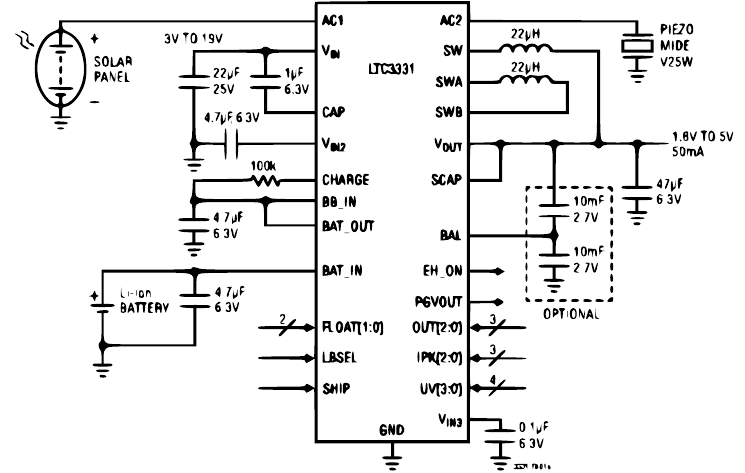
Figure 3. Typical application of the LTC3331 ([20]) using a solar panel and a piezo energy harvester to provide 1.8 to 5 V to the output and charge a single cell Li-Ion